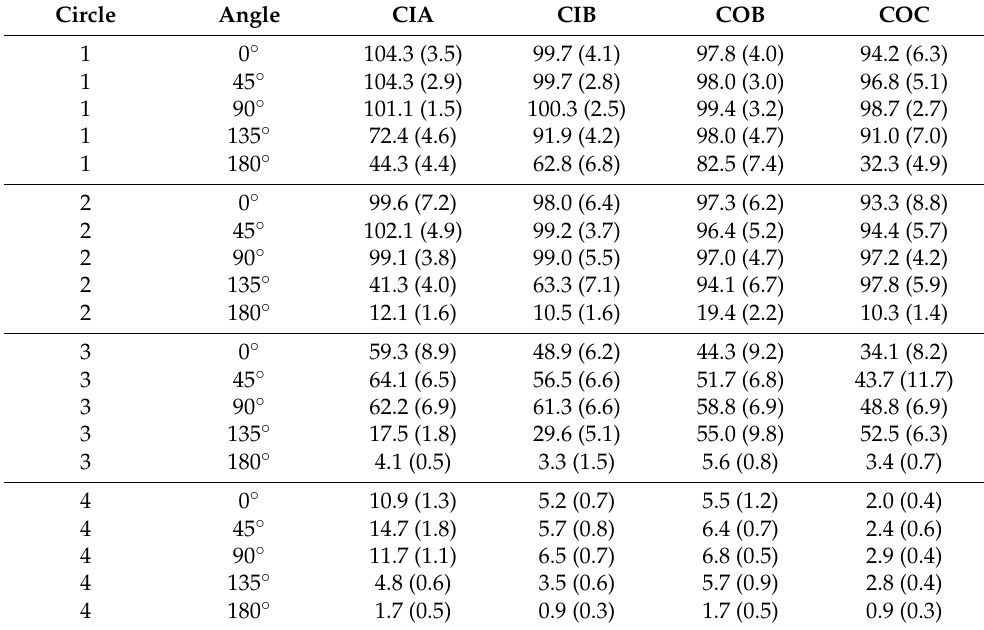
Table 1. Average relative surface dose values for the measurement points reported in the calibration certificates obtained from certificates from 12 different plaque lots. Standard deviation values given in brackets. Values are given in percentage and normalized to the CAX